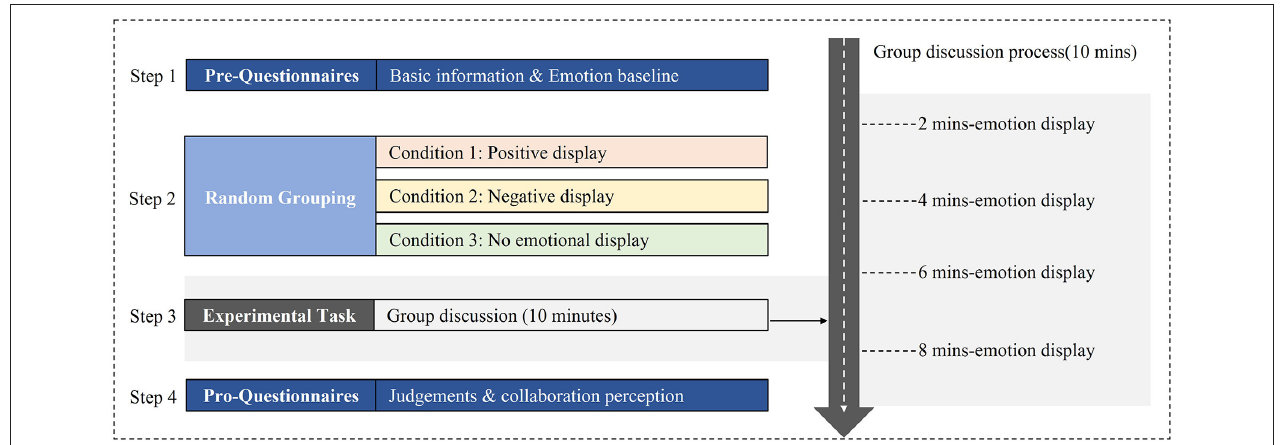
FIGURE 1 | Diagram of experiment design and